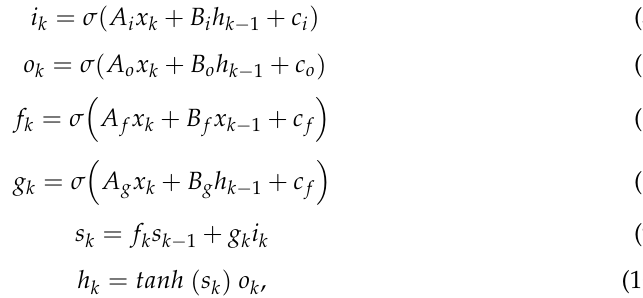
Figure 4. LSTM memory cell structure schematic with an inner recurrence s k , and outer recurrence h k , i k , o k , f k , and g k .